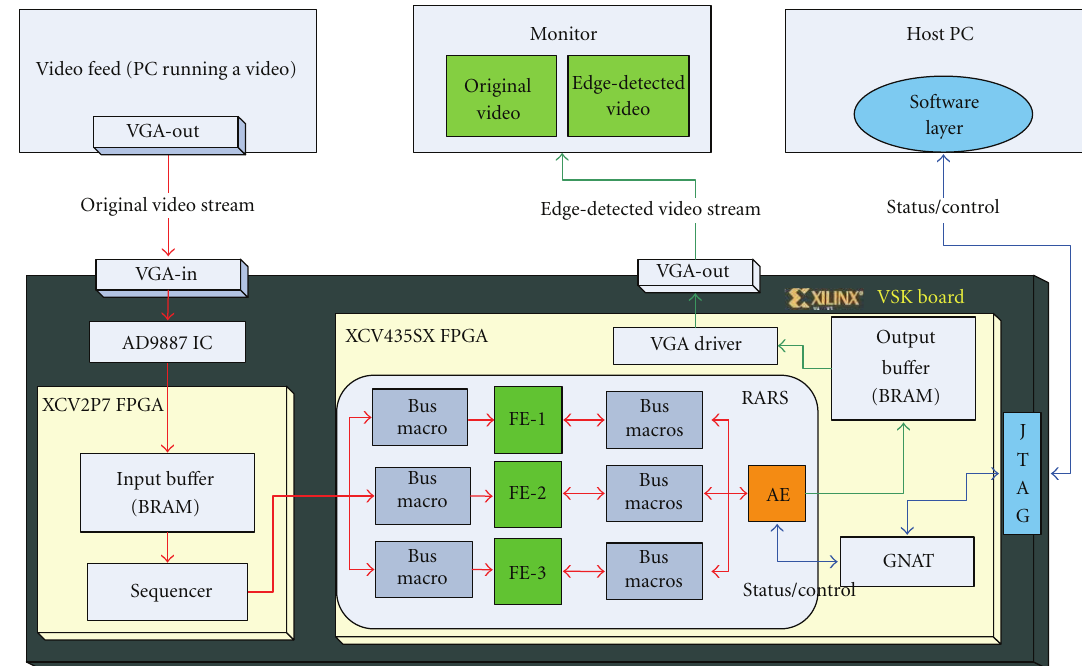
Figure 8: SMART experimental